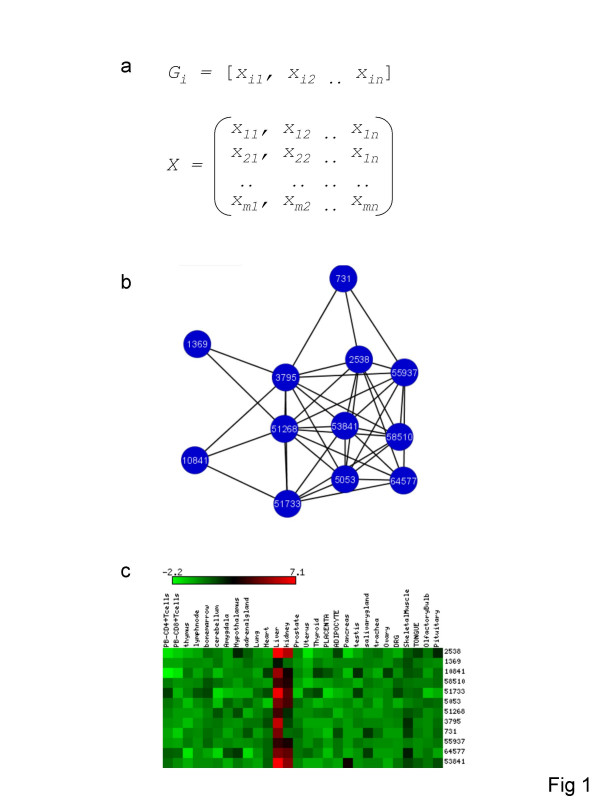
Gene coexpression networks. a) The expression profile of a gene i (Gi) can be represented as a row vector with dimensions (n) equal to the number of tissues (28); all profiles taken together yield an m × n gene expression matrix (X) where m = the number of genes (9,105), n = the number of tissues (28) and the expression value of Gi in tissue j is represented as xij [45]. b) Gene expression vectors can be compared using a number of different similarity (distance) measures such as the Pearson correlation coefficient (r). Genes (nodes) are connected by an edge if their vectors are sufficiently similar (e.g. r ≥ 0.7). A relatively tightly linked cluster (subgraph) of coexpressed genes is shown. c) Visual representation of the expression patterns of the genes in this cluster underscores their similarity. Color scale based on log2 (Gij/median Gi1...Gin).